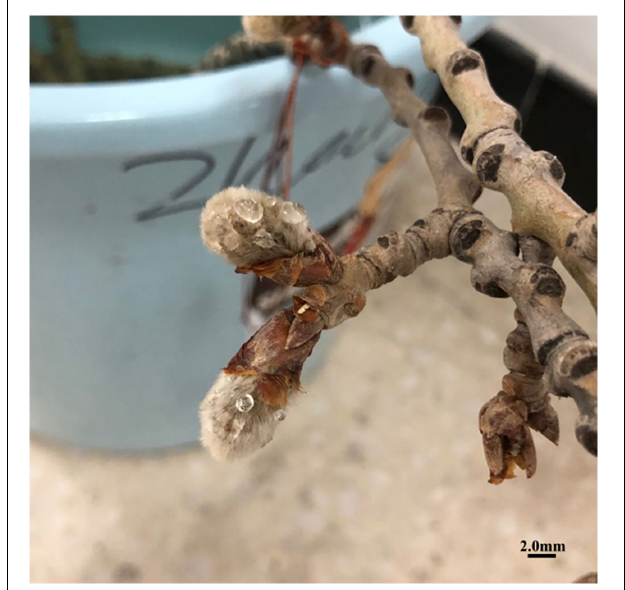
FIGURE 8 | Male flower buds of P. canescens after treatment with 0.5% colchicine solution. Scale bar = 2.0